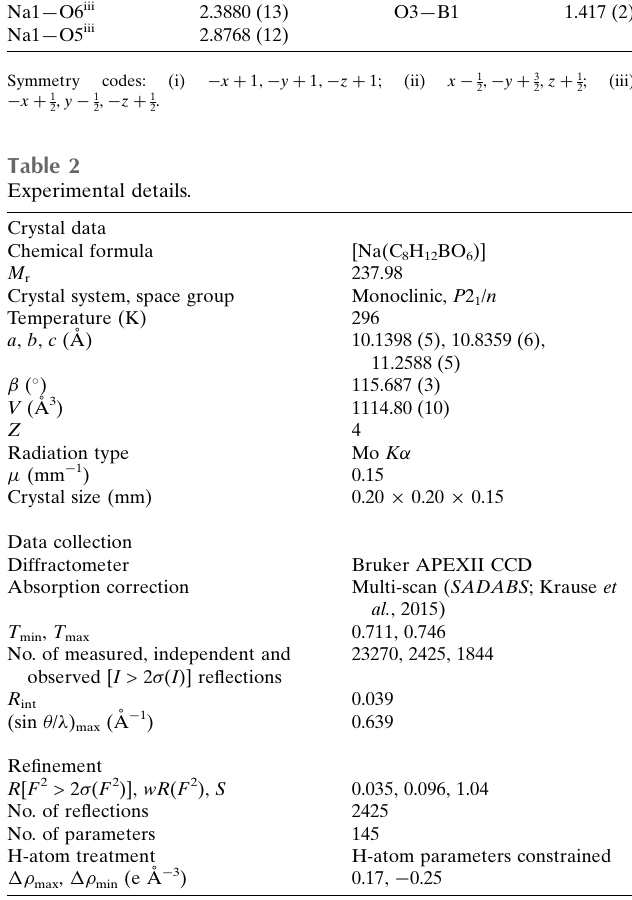
Table 1 Selected bond lengths (A˚